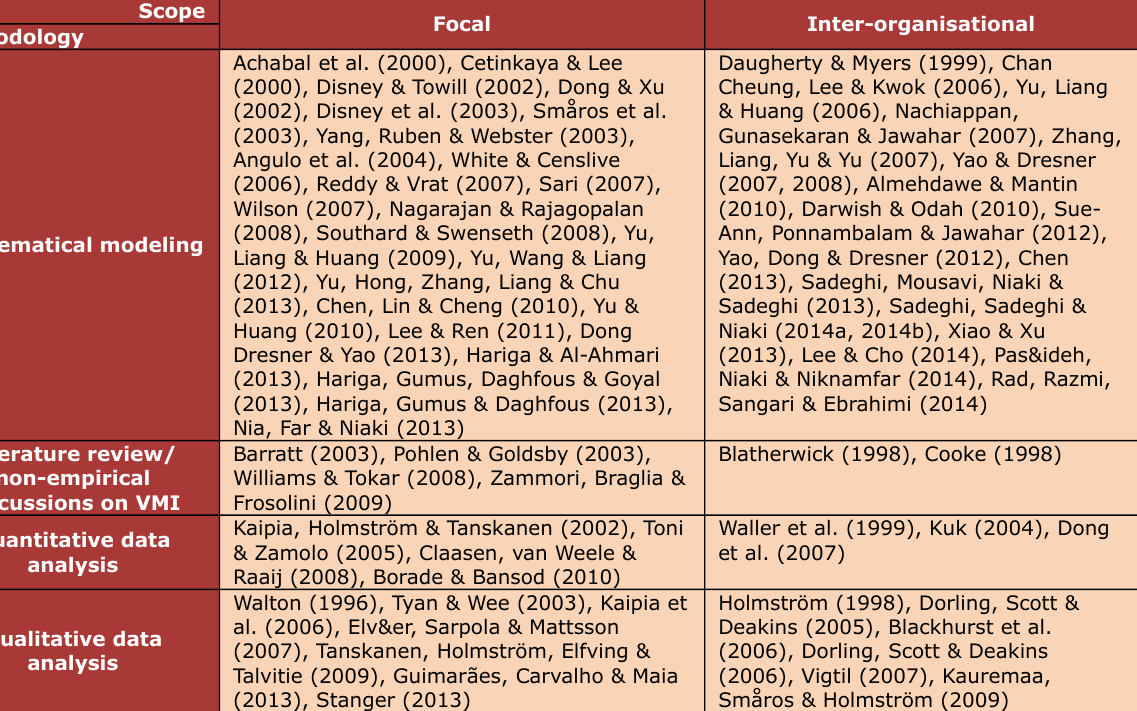
Table 1. Results of the literature review sorted by methodology and scope